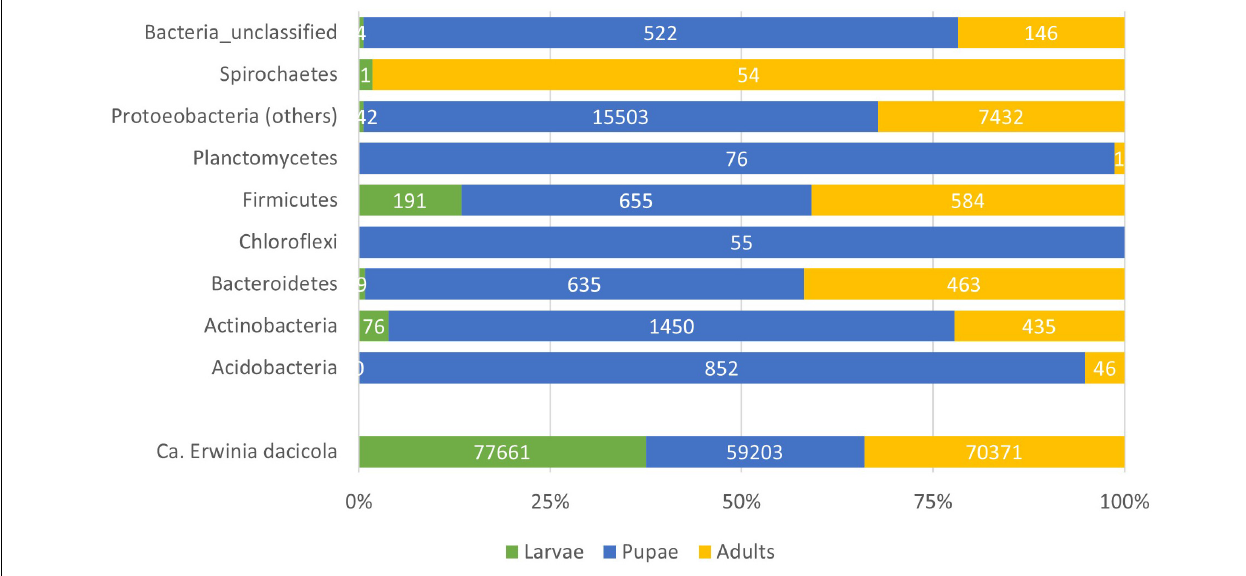
FIGURE 3 | Barplot of the total number of reads considering referred to a given Phyla within the bacteria. The Proteobacteria Candidatus Erwinia dacicola is represented separated from the other members of the Phylum due to its predominance in the bacterial